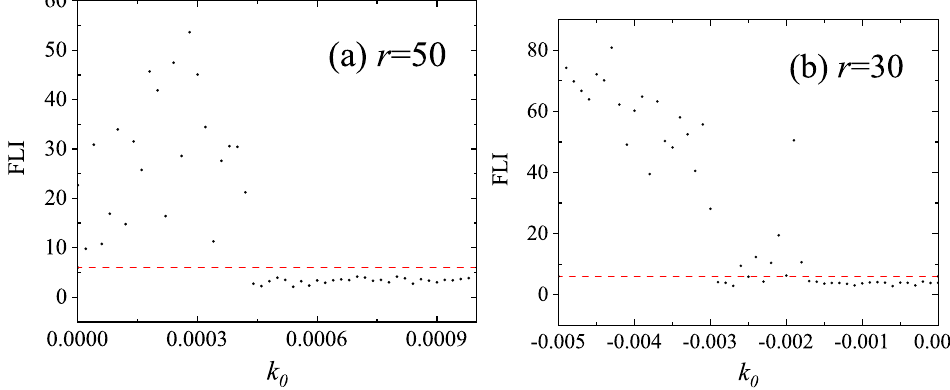
Figure 8. ( a ): Dependence of FLI on the positive deformation parameter k 0 in Figure 7a–c. The initial separation is r = 50. When k 0 > 4.2 × 10 − 4 , chaos begins to lose. ( b ): Dependence of FLI on the negative deformation parameter k 0 in Figure 7d–f. The initial radius is r = 30. When k 0 < 1.7 × 10 − 3 , the chaotic properties are